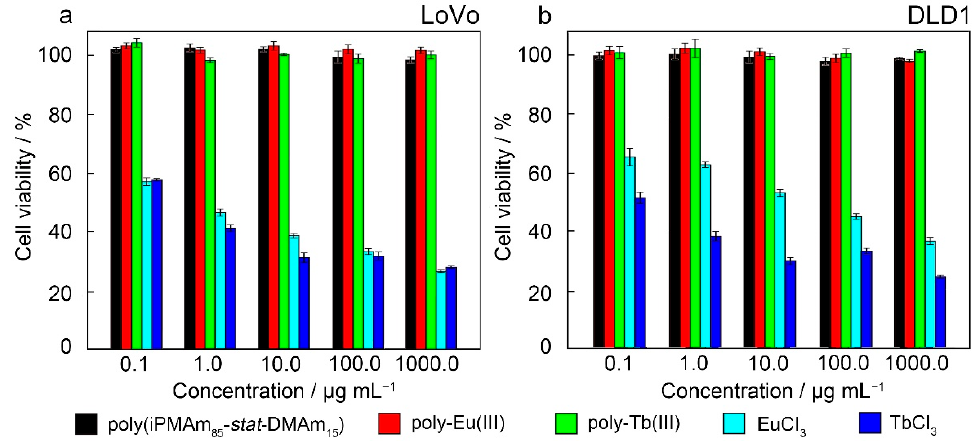
Figure 8. Cell viability of the human colon carcinoma cells ( a ) LoVo and ( b ) DLD1 incubated with poly(iPMAm 85 - stat -DMAm 15 ), poly-Eu(III), poly-Tb(III), EuCl 3 , and TbCl 3 under concentrations from 0.1 to 1000 µg mL − 1 by MTT assay for 48 h.